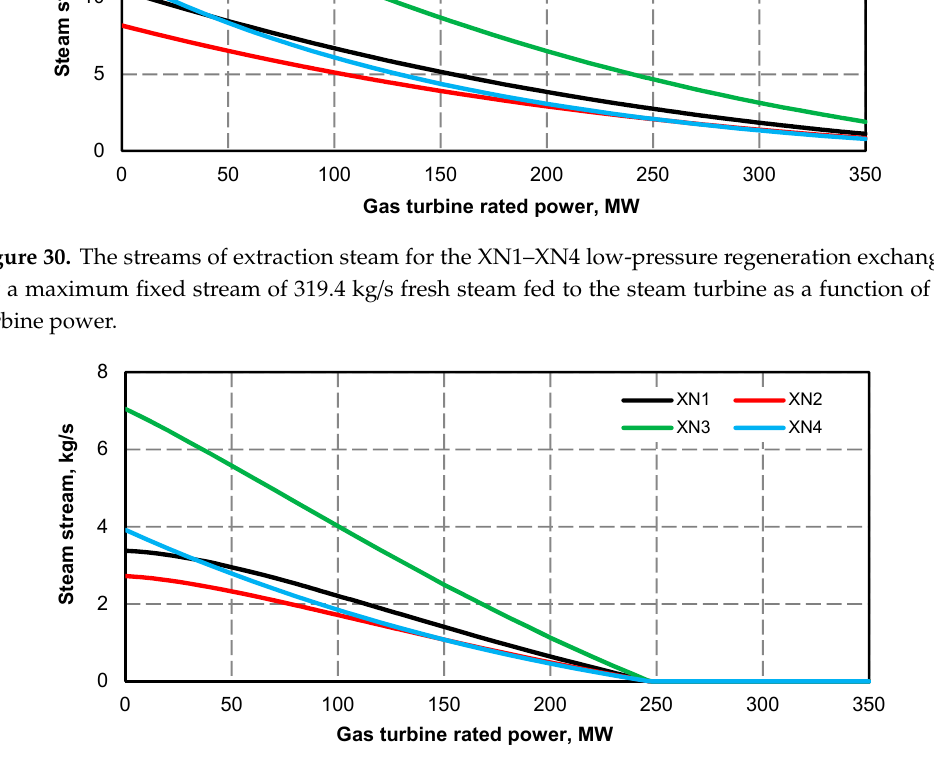
Figure 31. The streams of extraction steam for the XN1–XN4 low-pressure regeneration exchangers for a minimum steam boiler output of 133.3 kg/s and a gas turbine operating at a rated power.